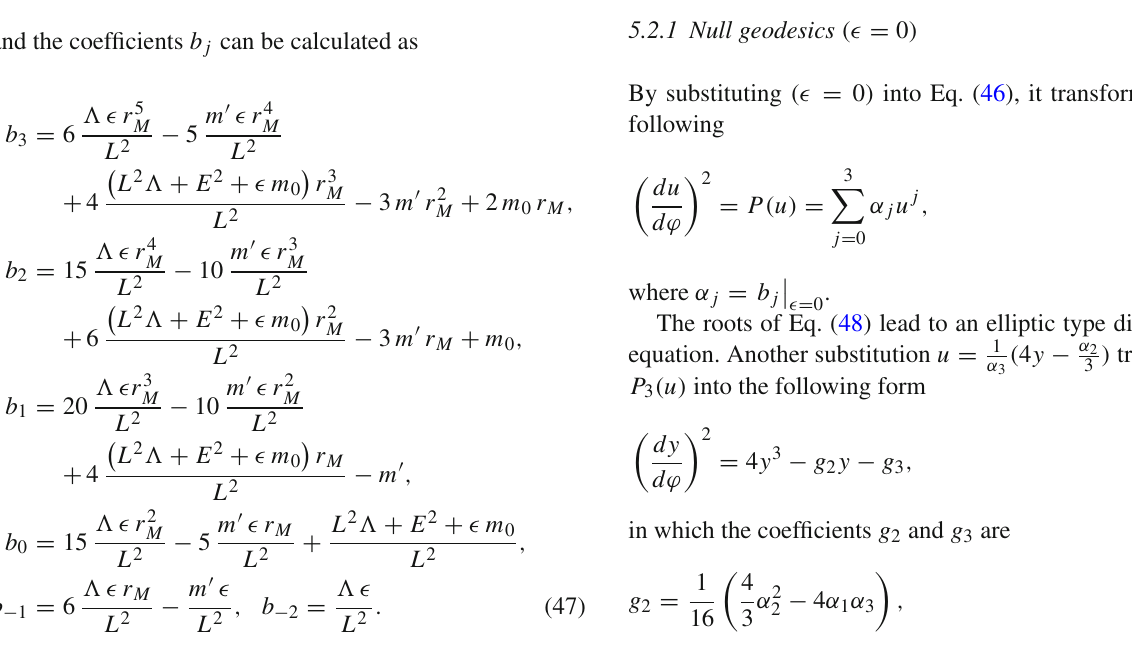
Fig. 5 Regions of stable and unstable circular orbits in the uncharged massive BTZ black hole with m 0 = 1 and positive (cid:4) . The dashed blue lines enclose the region of circular orbits, and the solid red lines indicate the innermost and outermost stable circular orbit. The dotted black lines indicate the horizons. On the left m (cid:5) = 1, on the right (cid:4) = 0 .